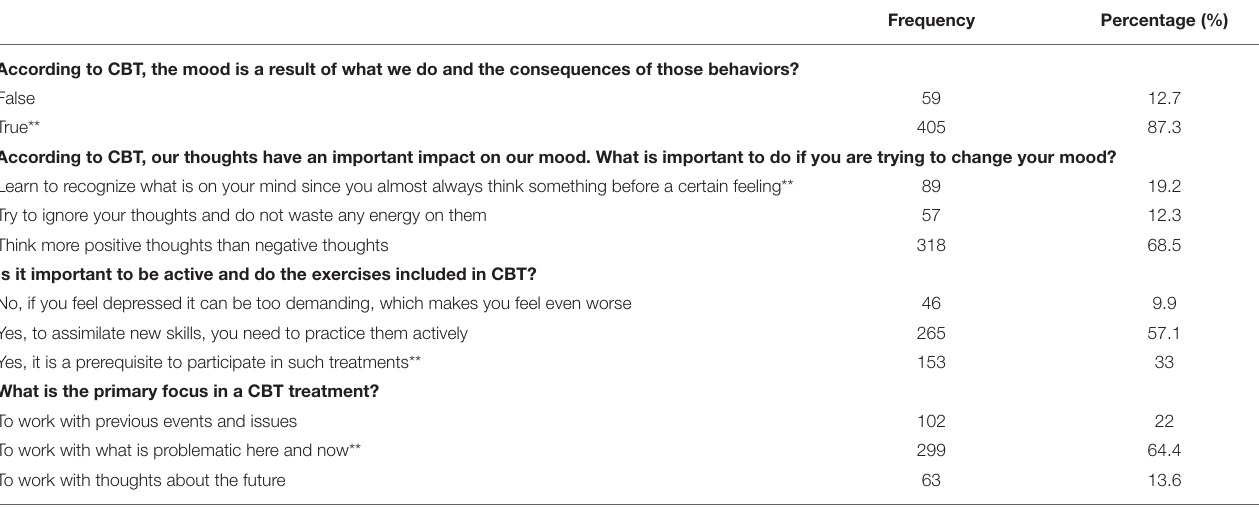
TABLE 2 | The parental knowledge about cognitive behavioral therapy (CBT) ( N = 464).